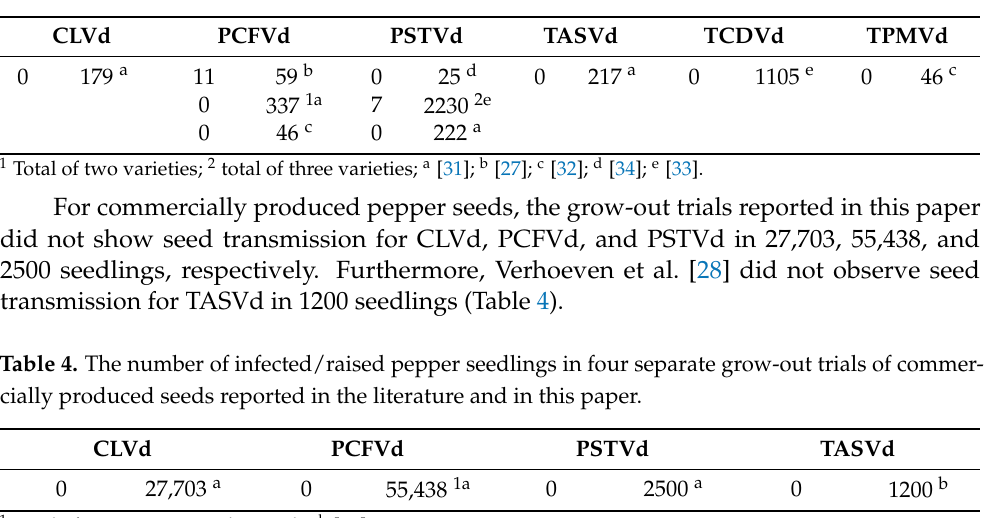
Table 3. The number of infected/raised pepper seedlings in ten separate grow-out trials of experi- mentally produced seeds reported in the literature.